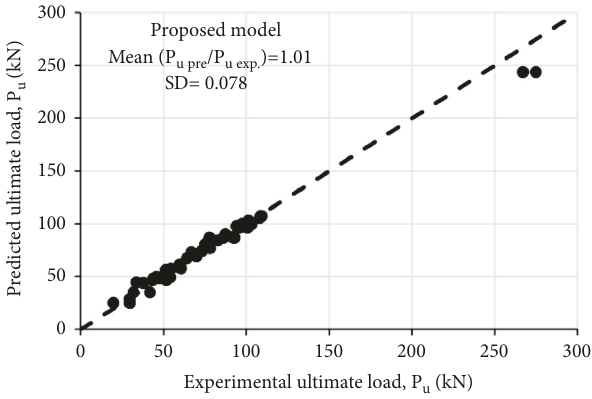
Figure 10: Comparisons of predicted vs. experimental ultimate load (Pu), evaluating proposed τ –s